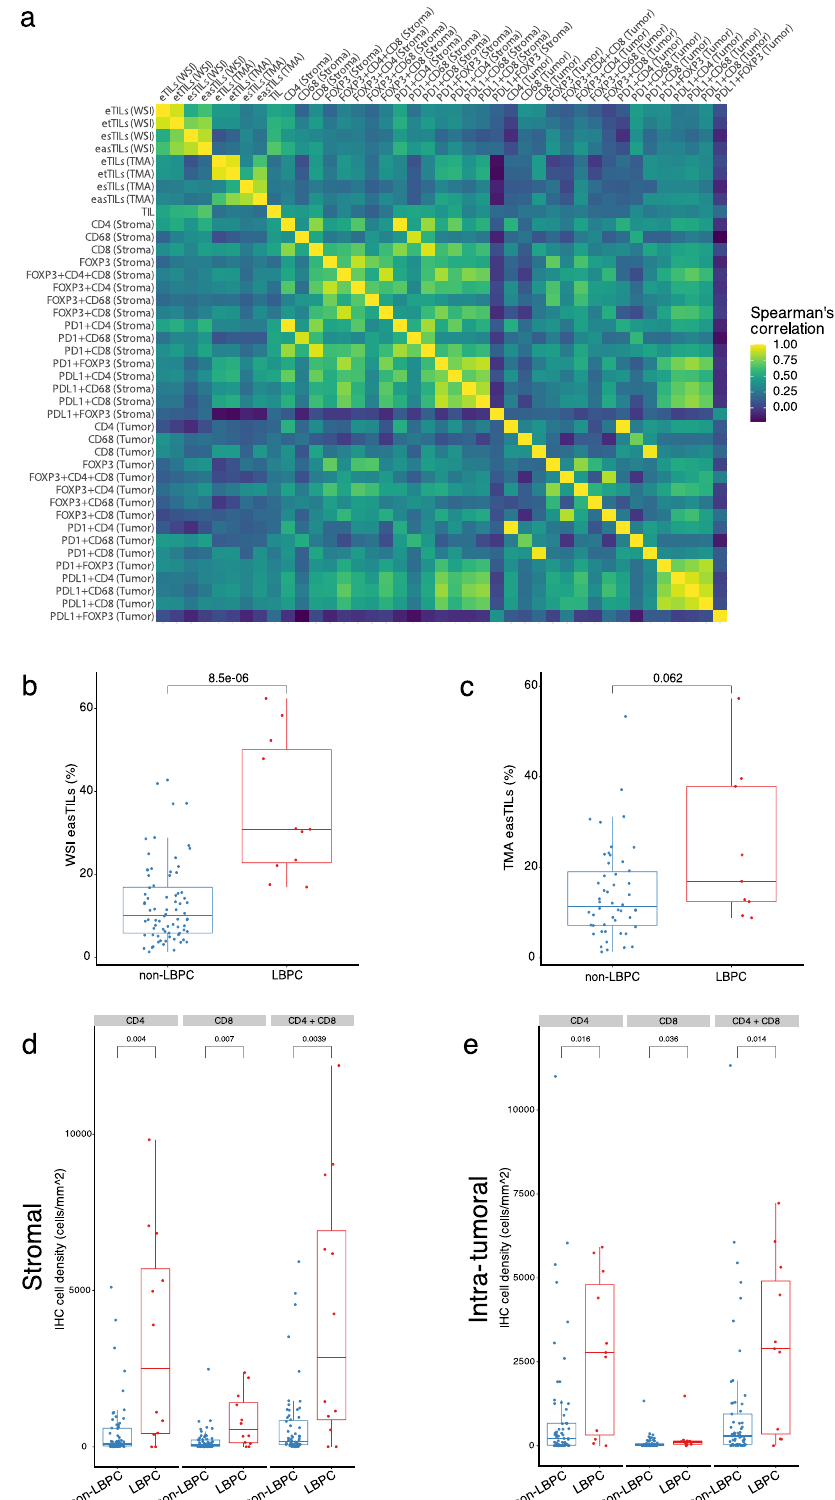
Fig. 3 Correlations of TILs with multiplex IHC. a Correlation matrix of the different variables derived from multiplex fl uorescent IHC, manual and digital TILs scoring; Correlations of easTILs in whole-slide images ( b ) and TMA ( c ) with manual TILs scoring in lymphocyte-predominant breast cancer (LPBC) and non-LPBC; Correlation between CD4 and CD8 stromal ( d ) and intra-tumoral ( e ) immune cell subsets with LPBC and non-LPBC based on manual TILs scoring.; In the boxplots, each box extends from the 25th to the 75th percentile, the midline represents the median, and the whiskers extend from – 1.5 × IQR to + 1.5 × IQR from the closest quartile, where IQR is the inter-quartile range; WSI: whole- slide images, TMA: tissue